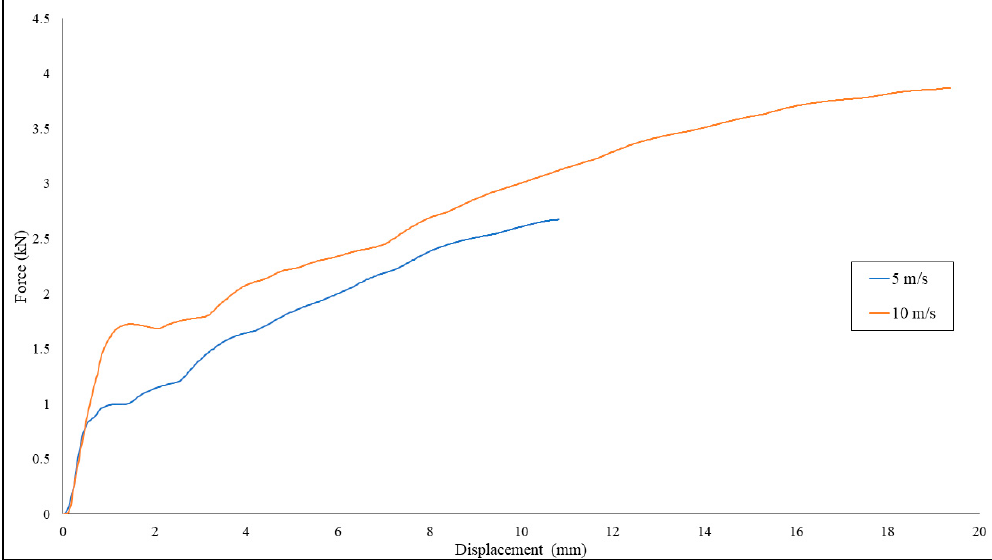
Figure 22. Mean crushing force of the battery model with loading speeds of 5 and 10 m/s.